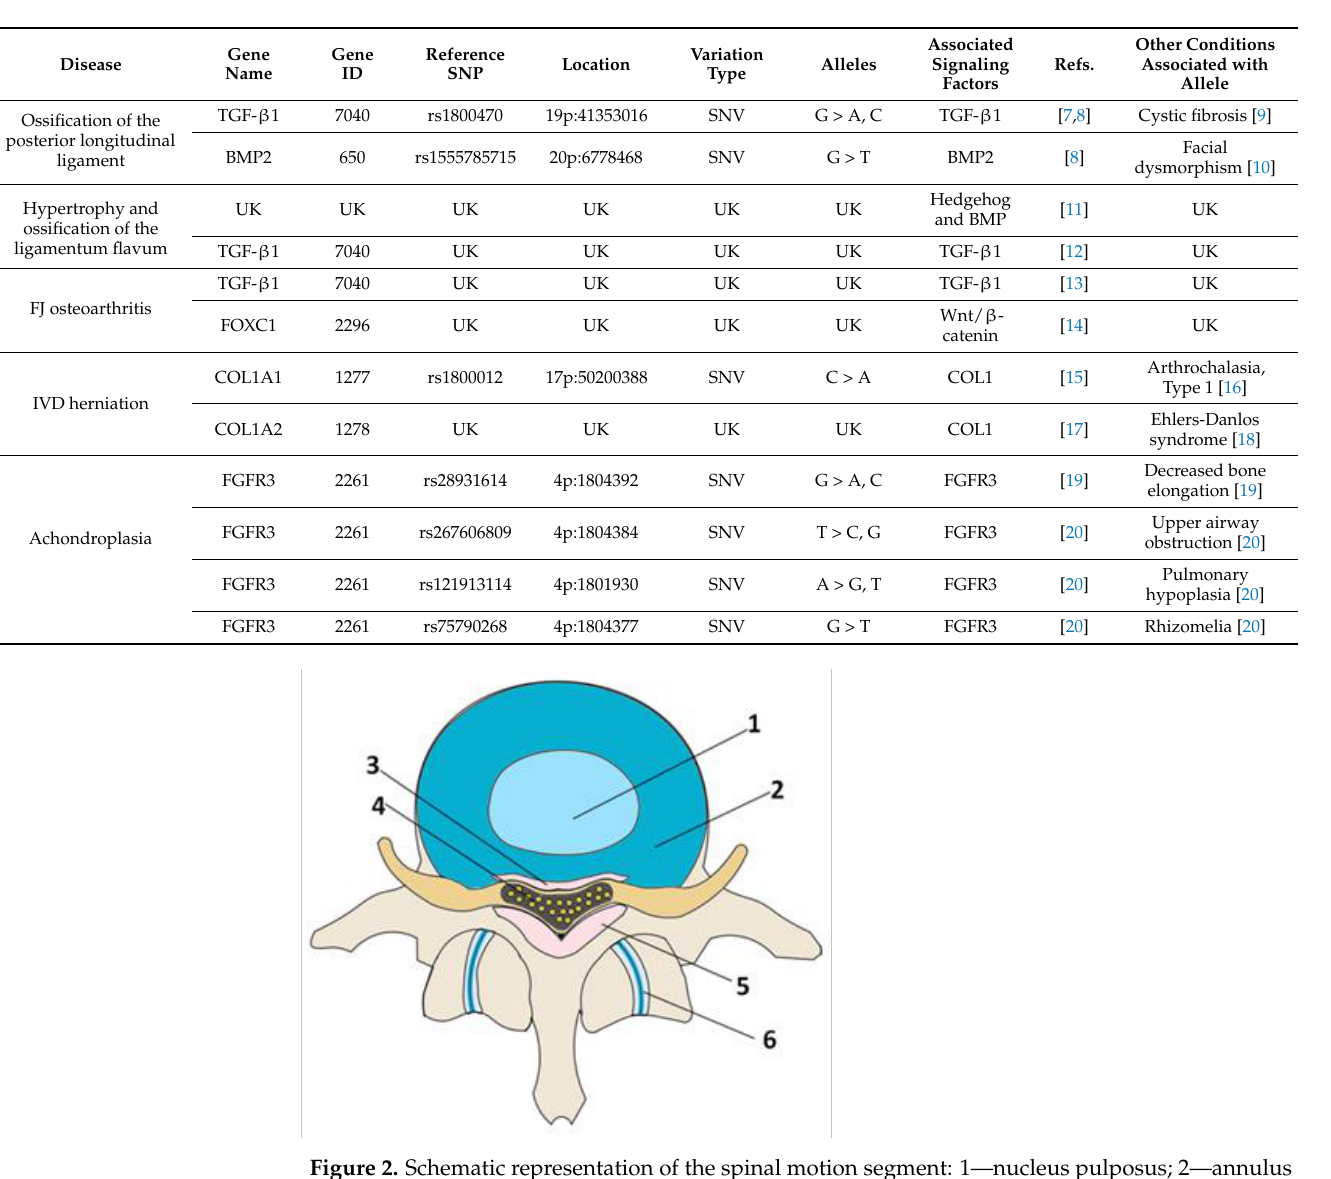
Table 2. Table of gene mutations associated with diseases inducing spinal stenosis. Unknown (UK) associations are also noted.